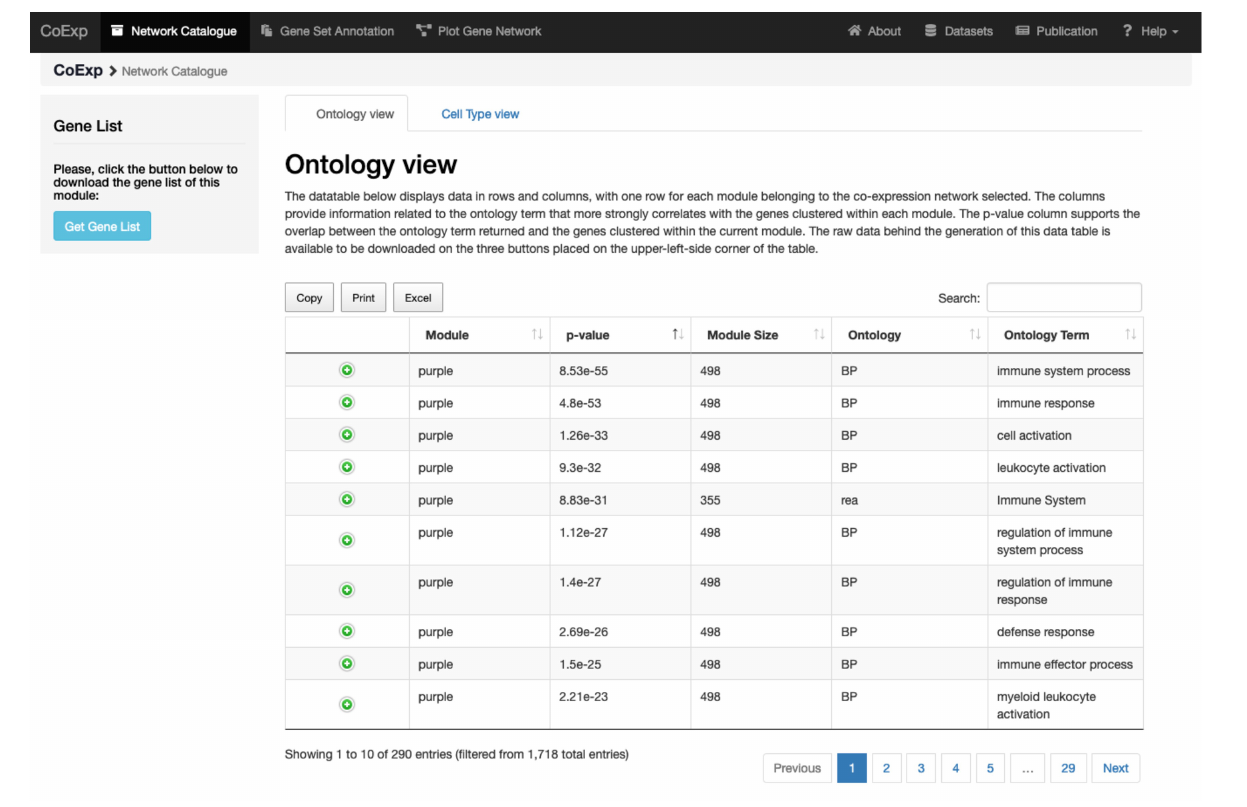
to use CoExp with this particular example is also available at the CoExp Help page, under the “Gene Set Annotation”